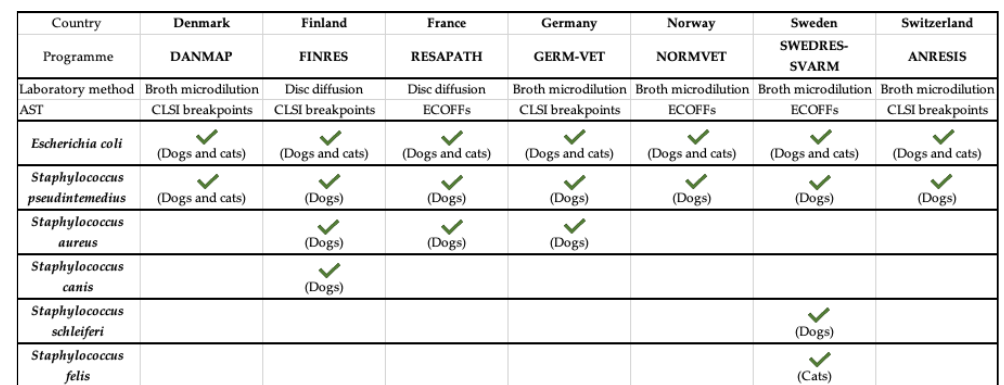
Figure 1. Summary of AMR surveillance programmes in the European Union. AST: ANTIBIOTIC Susceptibility Test; CLSI: Clinical Laboratory Standards Institute. Adapted from [10]. √: it indicates the bacteria included in each AMR surveillance program.